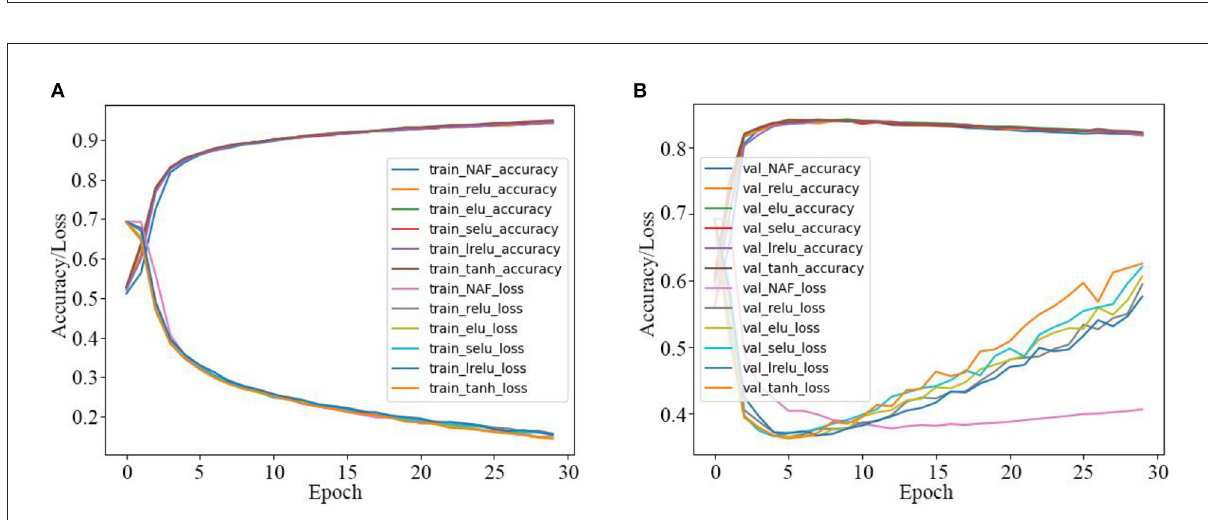
FIGURE9 Training and test curves of GRU model for IMDB sentiment classification. (A) Training curves. (B) Tested sentiment classification curves.